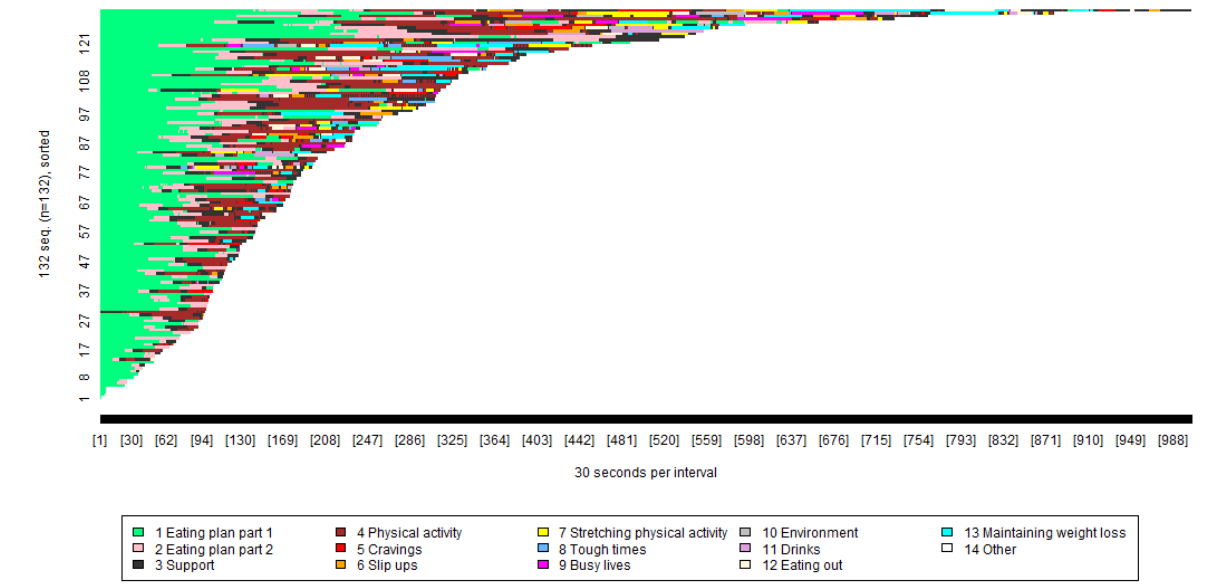
Figure 2. Visualization of POWeR usage of sessions by all intervention participants.